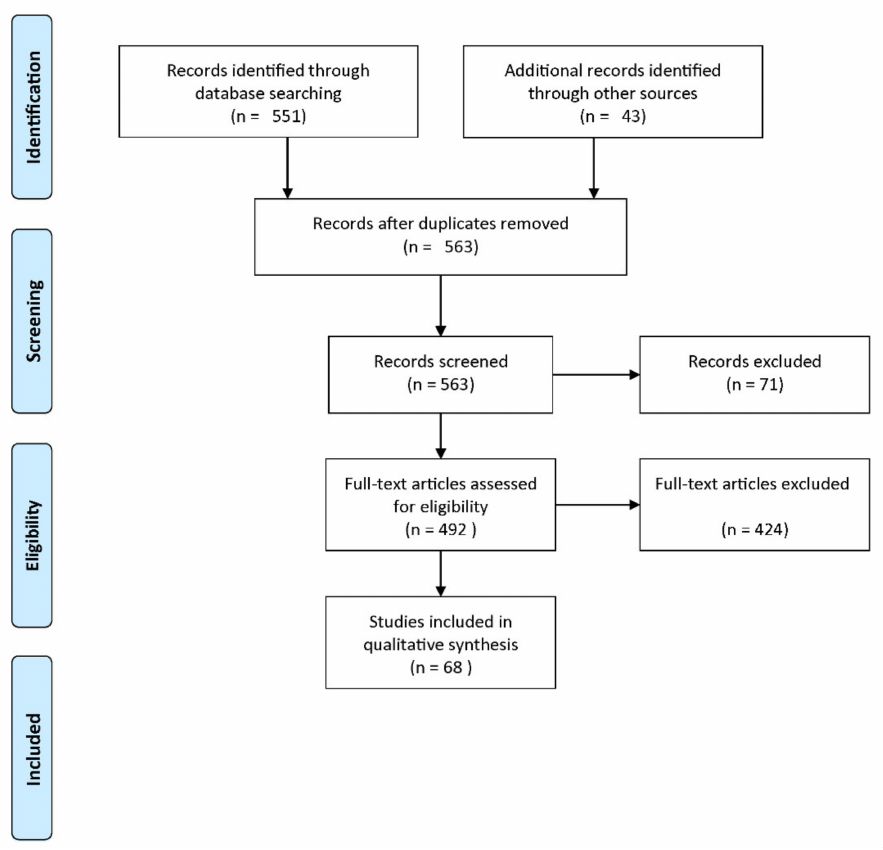
Figure 5. Flow diagram of the study selection process (reproduced with permission from